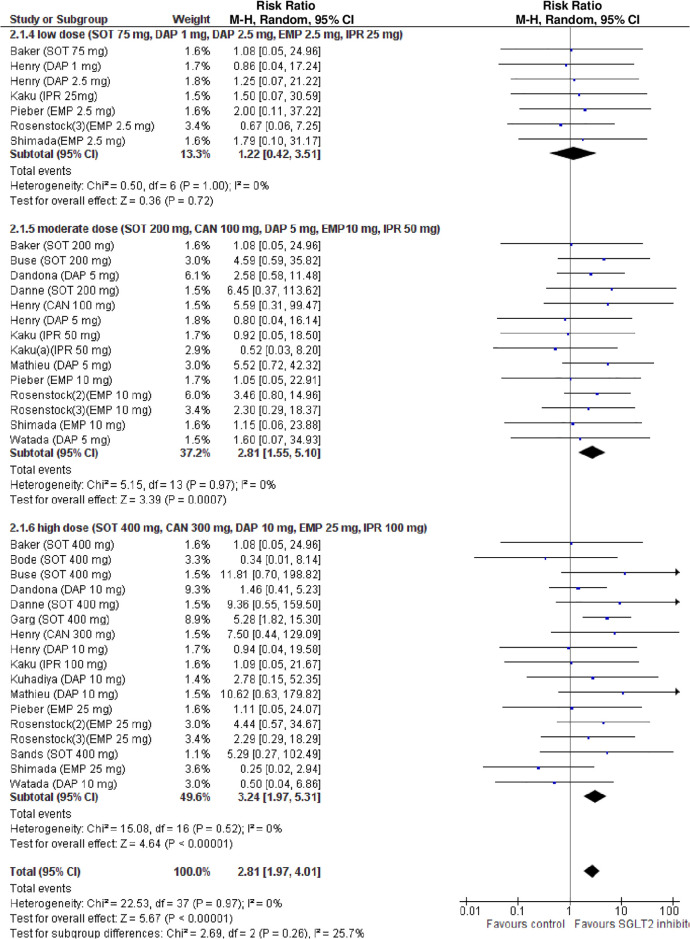
Forest plot of comparison: SGLT2 inhibitors, outcome: incident diabetic ketoacidosis (DKA).